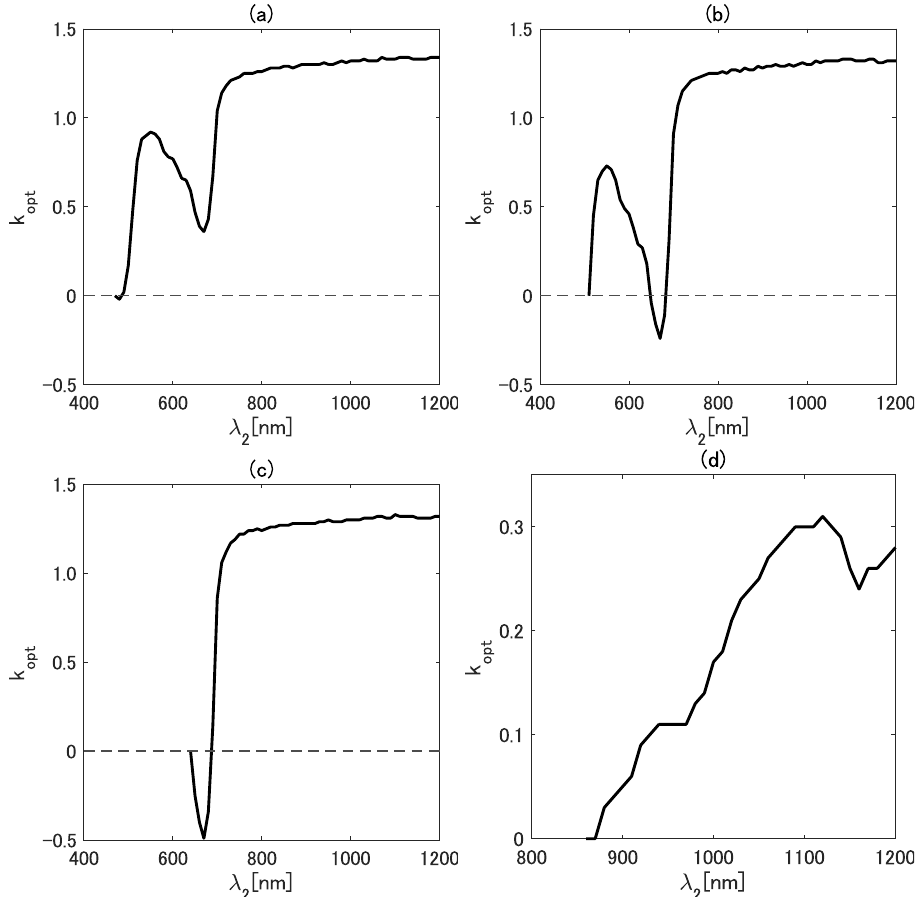
Figure 4. The value of k opt as a function of λ 2 for four λ 1 wavelengths (( a ) 470, ( b ) 510, ( c ) 640, and ( d ) 860